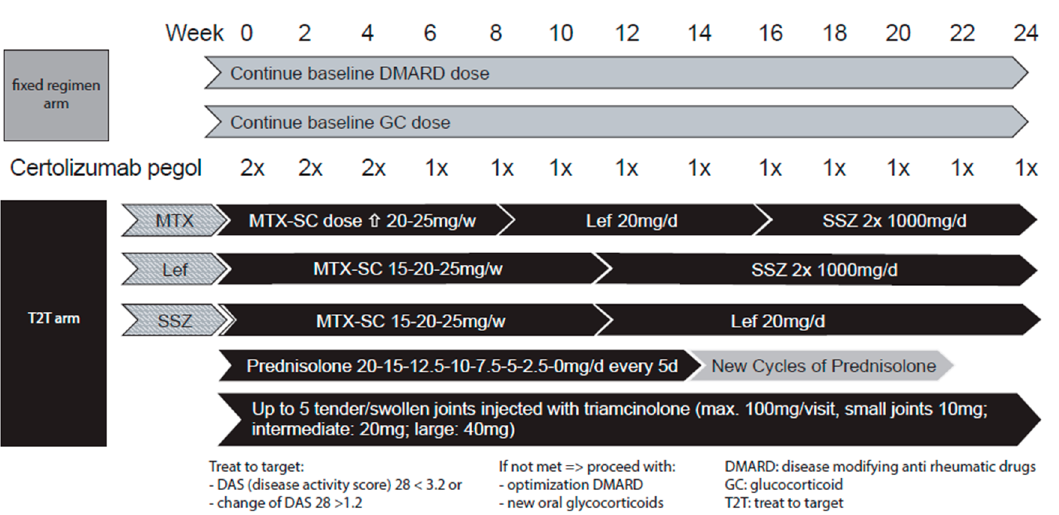
Figure 1. The treatment strategy arms: Flow diagram for treatment for escalation of disease-modifying anti-rheumatic therapy in RA patients. Patients were randomized into two arms: Fixed regimen (grey) or T2T (treat-to-target, black). Patients with both therapeutic arms were treated with certolizumab pegol (CZP). Fixed regimen arm: Baseline GCs and csDMARDs were continued at a stable dose throughout the study. T2T arm: Depending on the csDMARD used before the study (shown as a striped arrow), the csDMARD therapy was modified. In parallel, a cycle of oral GCs was initiated, and up to five tender and/or swollen joints were injected with triamcinolone. The response criteria for the patients in the T2T arm are listed below. If these response criteria were not met, therapy was modified according to the mechanism described, and a new cycle of oral GCs was initiated. Joint injections were always conducted independently of achieving the pre-set goal of the T2T strategy if they were tender and/or swollen. Lef, leflunomide; MTX-SC, subcutaneous methotrexate; SSZ, sulphasalazine.